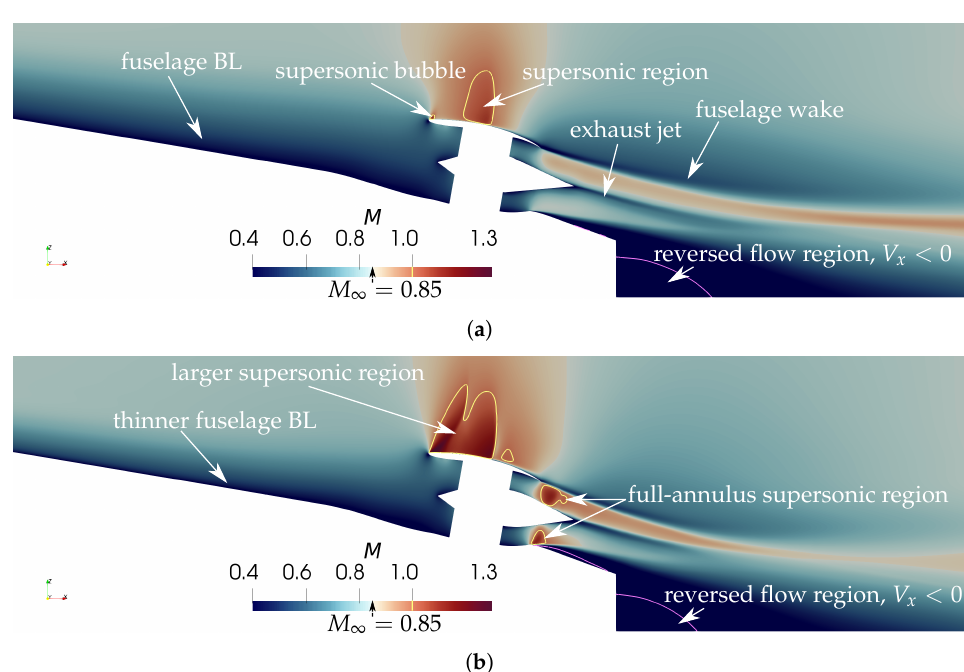
Figure 6. Mach number M at centre plane, with M = 1 contour in yellow. ( a ) Case I. ( b ) Case II.